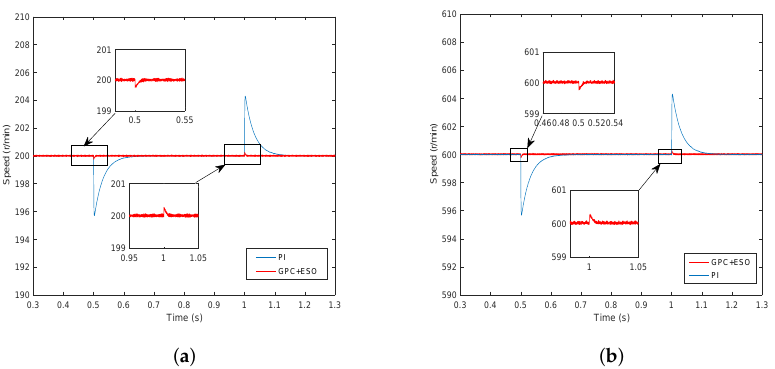
Figure 3. Simulation curves of speed response under the load disturbance. ( a ) n = 200 r/min; ( b ) n = 600 r/min.